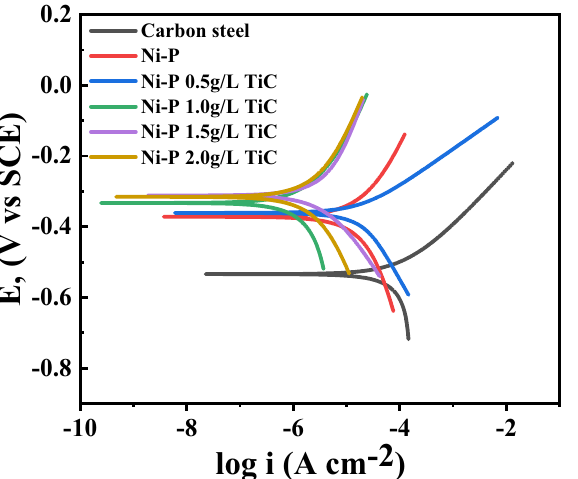
Figure 15. Potentiodynamic profiles of carbon steel, Ni–P and Ni–P–TiC composite coating with increasing concentration of TiC.